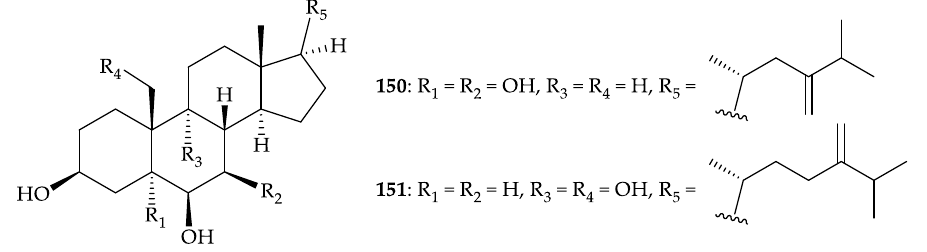
Figure 23. Structures of 23-nor-ergost-24-ene-3β,5α,6β,7β-tetrol ( 150 ) and ergost-24-ene-3β, 6β,9α,19- tetrol ( 151 ).